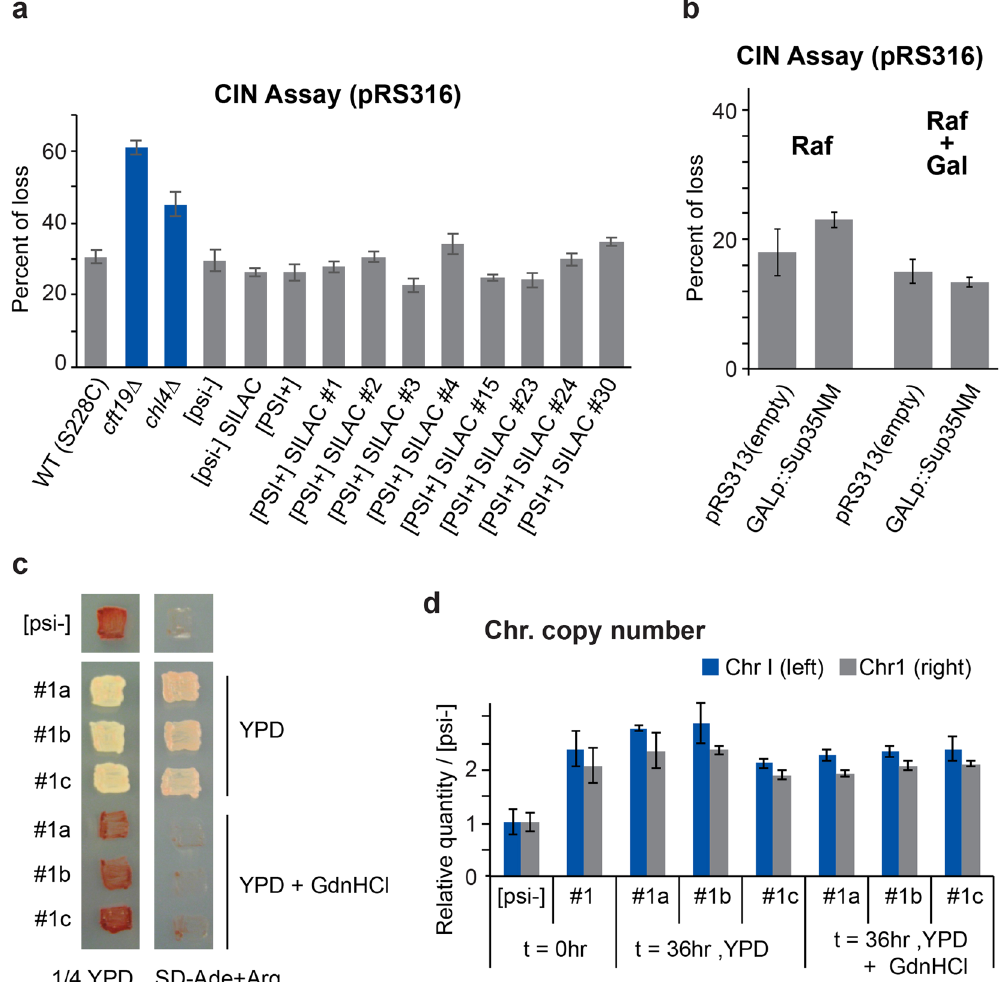
Figure 4. Chromosome instability (CIN). ( a ) The indicated strains transformed with pRS316 were plated on YPD to allow the formation of colonies for 2 days. The colonies were then replicated on SD + Arg − Ura plates. The percentage loss of the URA3 -containing plasmid was calculated by comparing the number of colonies on each plate: (YPD − SD)/YPD. The standard deviations were calculated from 5 replicates. ( b ) The percentage of pRS316 loss was calculated as in a, but after the incubation of [ psi − ] SILAC cells transformed with the indicated HIS3 plasmids in YP-raffinose media with or without galactose for 48 hours. ( c , d ) Relative quantity of DNA from chromosome I left and right arm compared to [ psi − ], using qPCR. Genomic DNA was extracted from [ PSI + ] #1 samples grown in YPD before (t = 0hr; YPD) and after curing in 4 mM guanidine hydrochloride (GdnHCl) (t = 36 hr; YPD + GdnHCl). [ psi − ] was used as a control, as well as [ PSI + ]#1 grown for 36 hrs in YPD alone (t = 36 hr; YPD). Strains were verified to be cured by plating on 1/4 YPD (no GdnHCl) and SD − Ade + Arg ( c ). Gene regions from chromosome 1 left and right arms were done in triplicates, while error bars represent standard deviation ( d